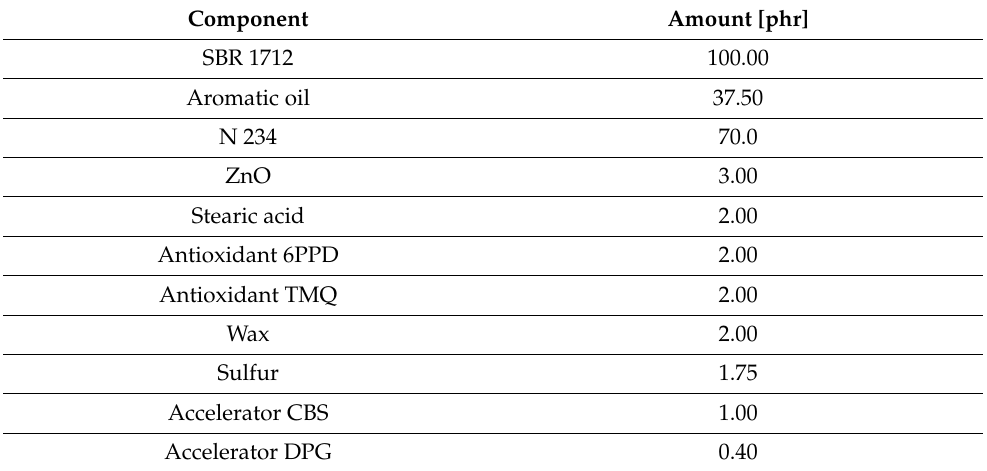
Table 1. Recipe of the high-performance tread